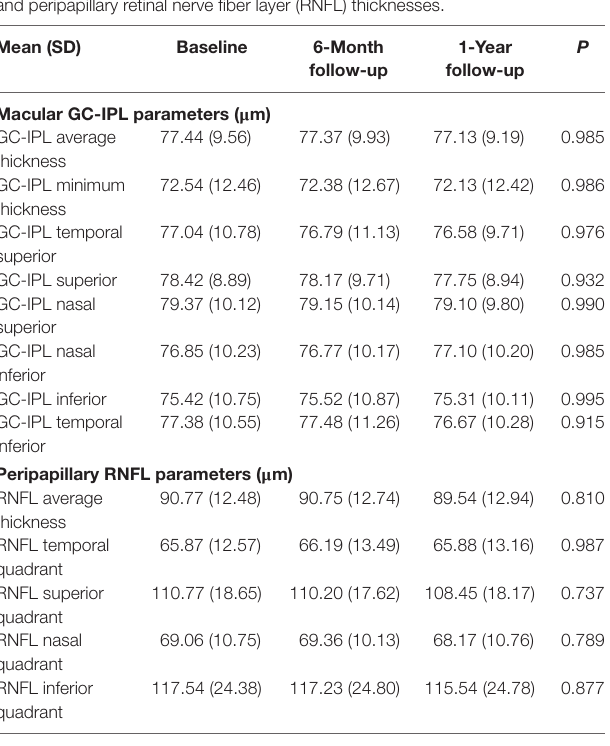
TaBle 2 | Distributions of macular ganglion cell-inner plexiform layer (GC-IPL) and peripapillary retinal nerve fiber layer (RNFL) thicknesses.